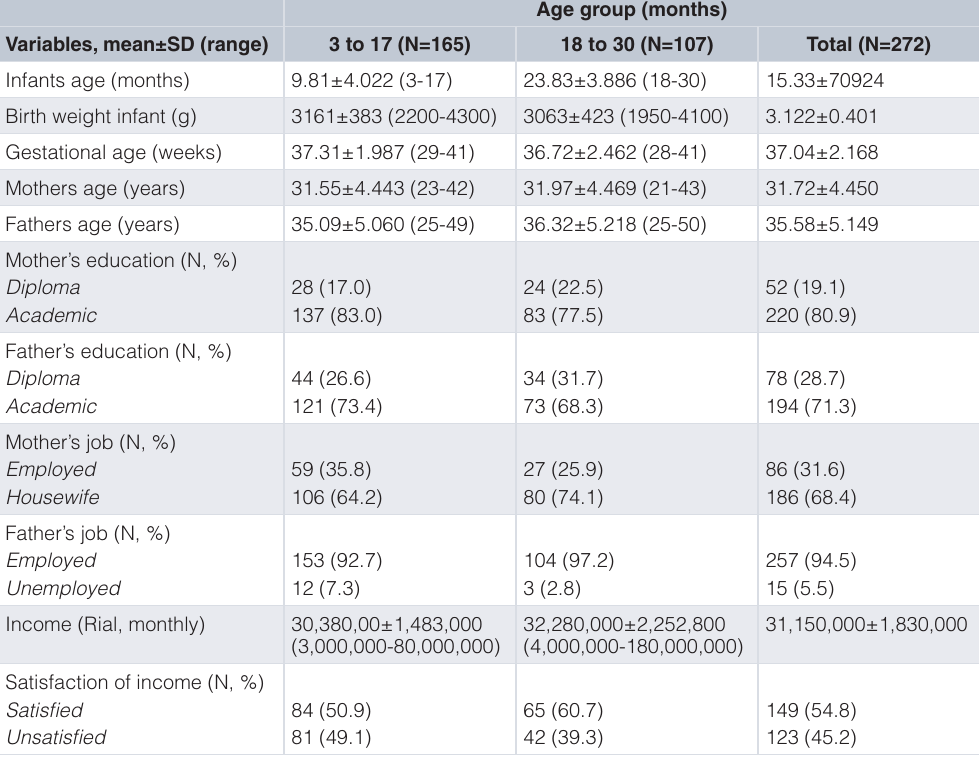
Table 1. Demographic characteristics of the family according to age group of the infants and toddlers.